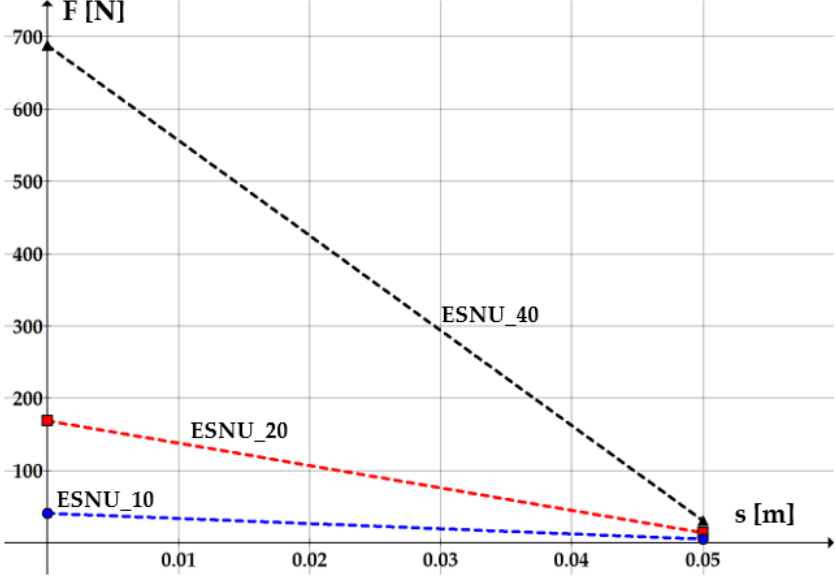
Figure 4. Variation of the forces developed by the studied pneumatic cylinders.